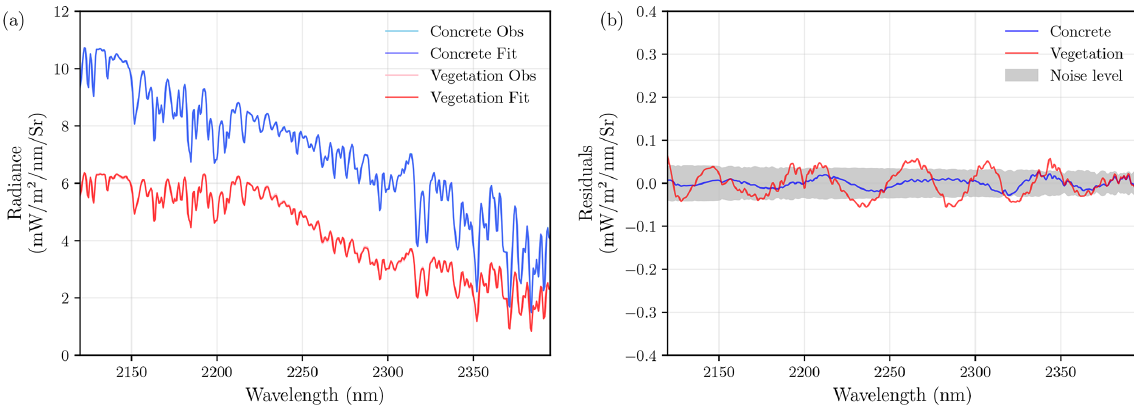
Figure 8. (a) The observed spectra through exactly the same CH 4 source over two different surfaces, namely construction concrete and vegetation, as observed by an instrument with a FWHM of 1.5nm and the best spectral fit. (b) The associated spectral residuals and an expected 1 σ noise level for the instrument